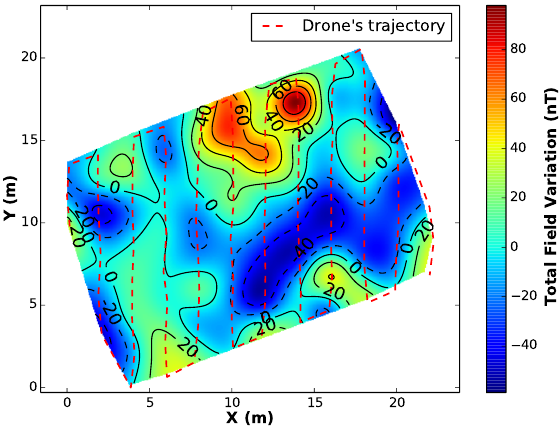
Figure 8. Illustration of the interpolated data represented by a coloured contour